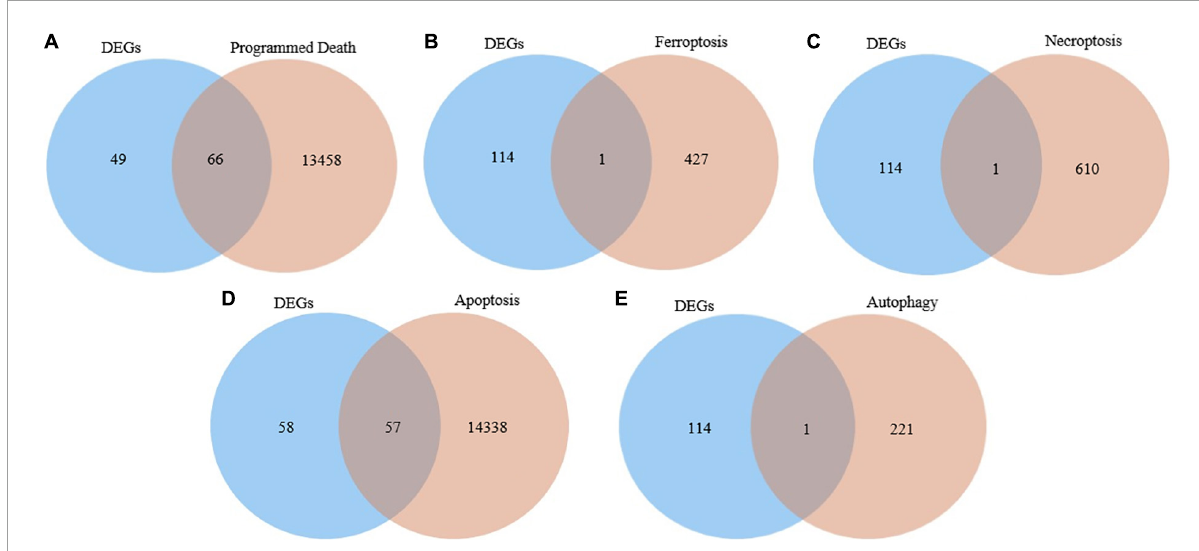
FIGURE2 Identification of the candidate programmed cell death (PCD)-related differentially expressed genes. (A) Venn diagram to identify common genes between differentially expressed genes and programmed death related genes. (B) Venn diagram to identify common genes between differentially expressed genes and ferroptosis related genes. (C) Venn diagram to identify common genes between differentially expressed genes and necroptosis related genes. (D) Venn diagram to identify common genes between differentially expressed genes and apoptosis related genes. (E) Venn diagram to identify common genes between differentially expressed genes and autophagy related